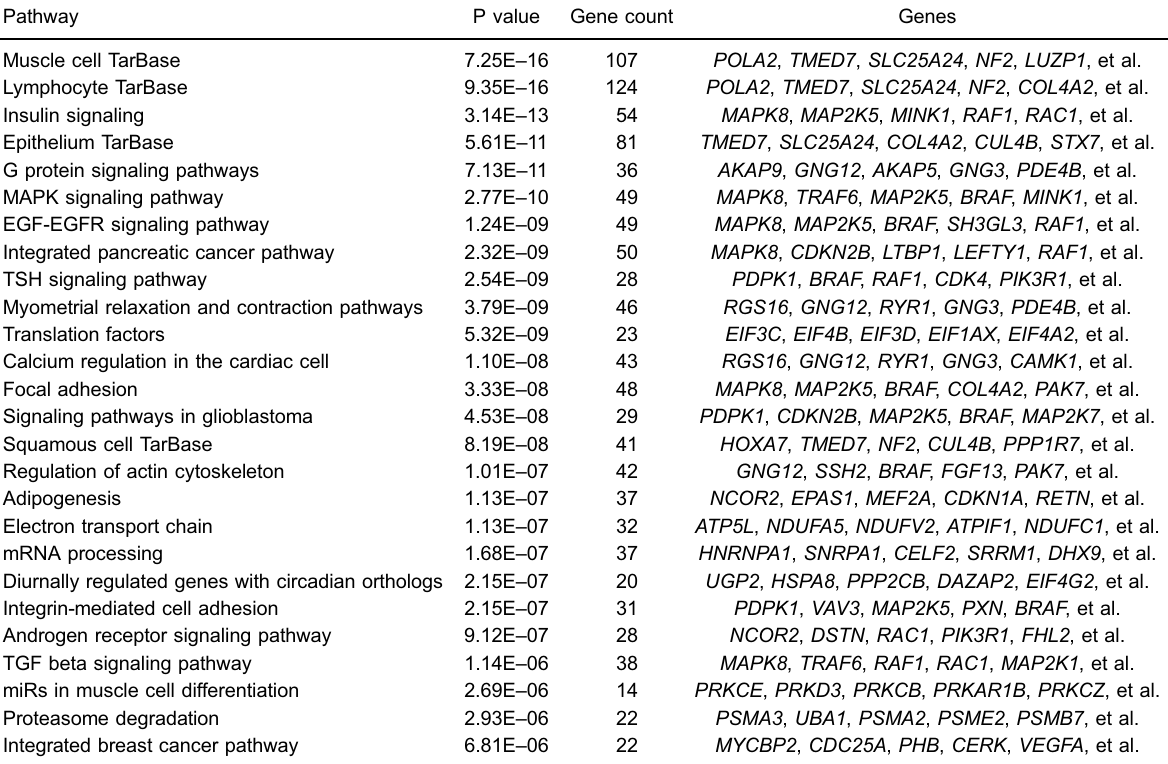
Table 1. Biological pathways enriched by differentially expressed genes (DEGs) in dilated cardiomyopathy.